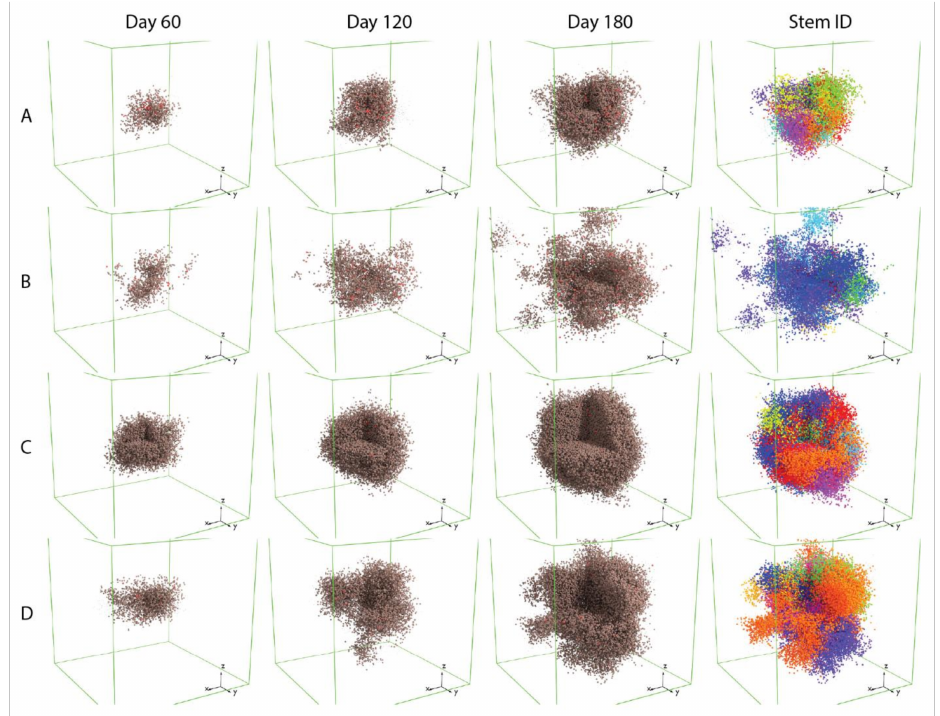
Figure 3. Tumor morphology affected by cancer stem-like cell mechanisms. Part of the tumor in the images is removed to make the interior of the tumor visible. Brown: progenitor cells; red: cancer stem cells (CSC); grey: senescent cells. ( A ) Low asymmetric division probability, low migration rate; ( B ) low asymmetric division probability, high migration rate; ( C ) high asymmetric division probability, low migration rate; ( D ) high asymmetric division probability, high migration rate. In the 4th column (Stem ID, in which a unique ID is assigned to each stem-like cancer cell and its descendants), each color represents progenitor cells originating from the same CSC. A time-lapse video showing the spatio-temporal tumor development with pseudo colors corresponding to cancer cells’ stem ID is included in the Supplementary Materials (Supplement_CSC.mp4). Each box represents 3 × 3 × 3 mm